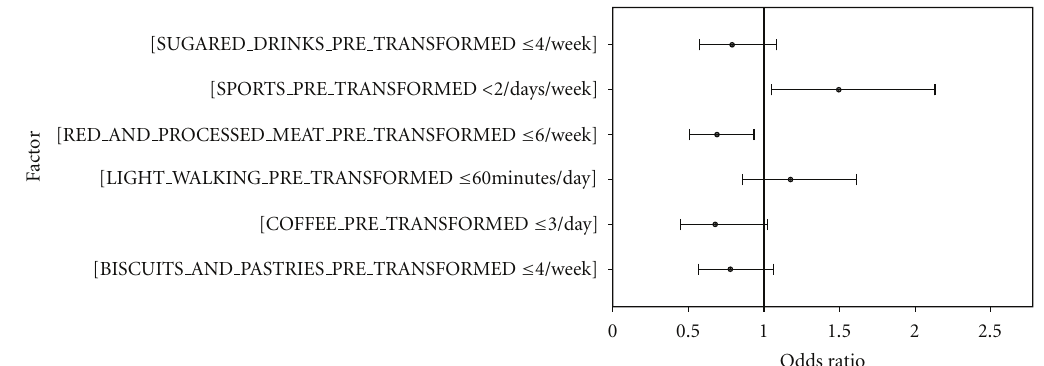
Figure 3: Odds ratio (95% CI) of specific cuto ff points of lifestyle factors when applying logistic regression.